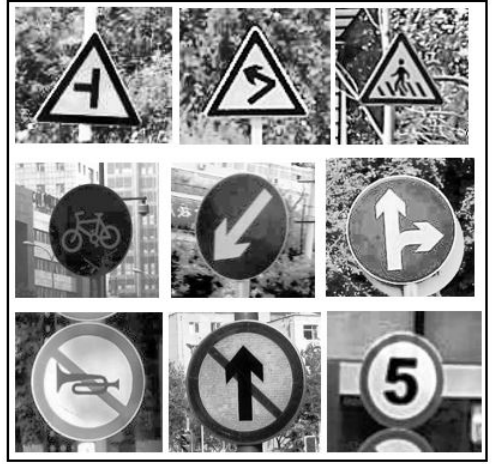
Figure 6. Sample images of the TSRD